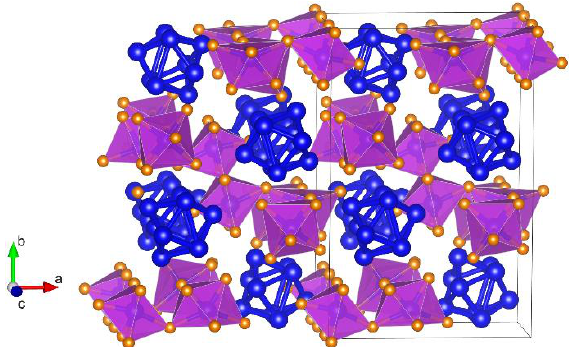
Figure 1. Polyhedral representation of the crystal structure of Bi 6 Br 7 . Bismuth atoms are shown in blue, bromine in orange. Black lines depict the unit cell.